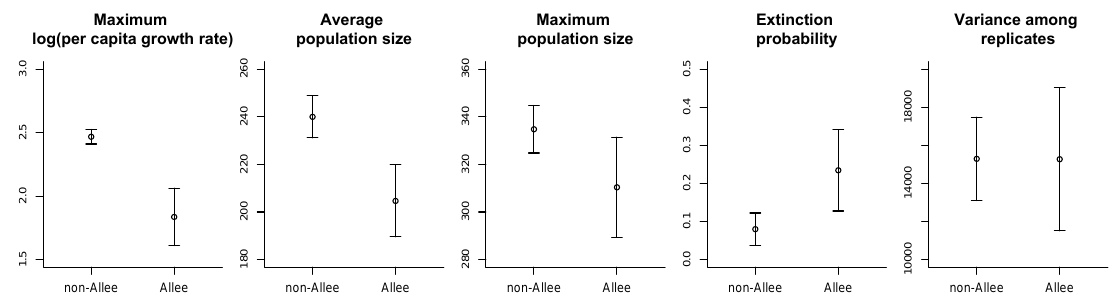
Figure 3. Comparison of demographic parameters between populations with or without an Allee effect. All graphs represent mean +/- 2